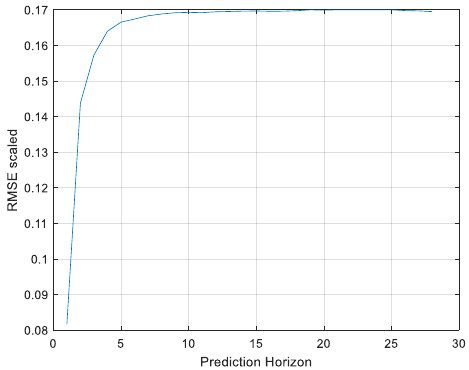
Figure 10. RMSE over the prediction horizon — M 1.